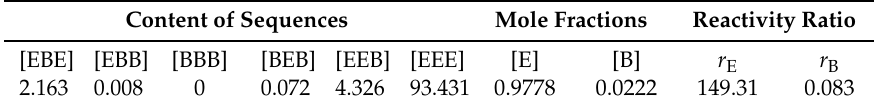
Table 3. The content of different sequences for the copolymer and reactivity ratios for the monomers. Content of Sequences